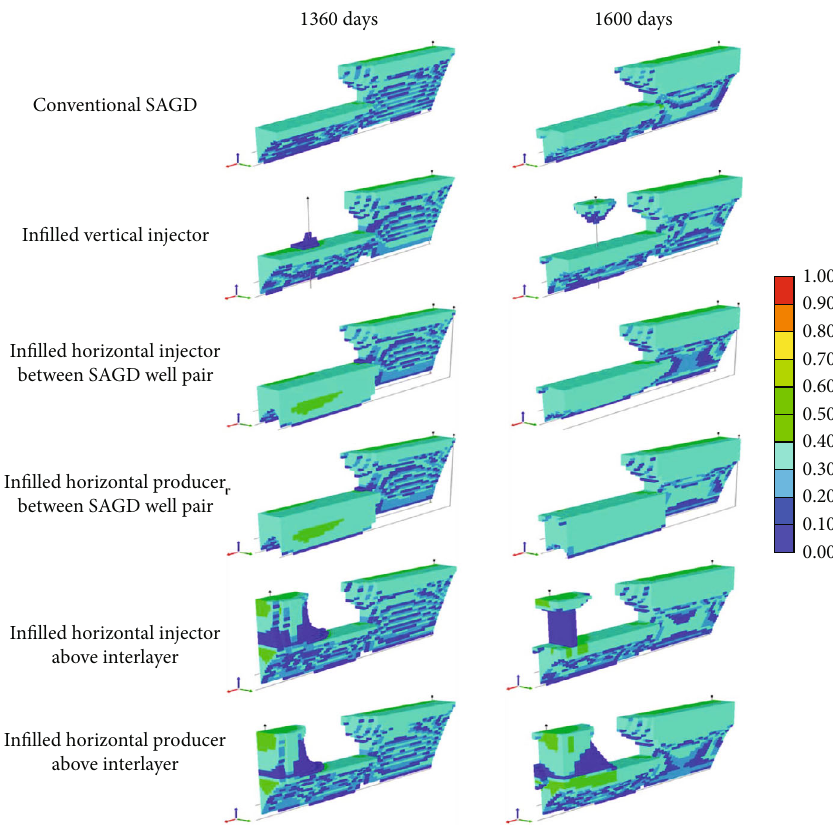
Figure 9: Gas saturation of di ff erent schemes for model B at di ff erent time.